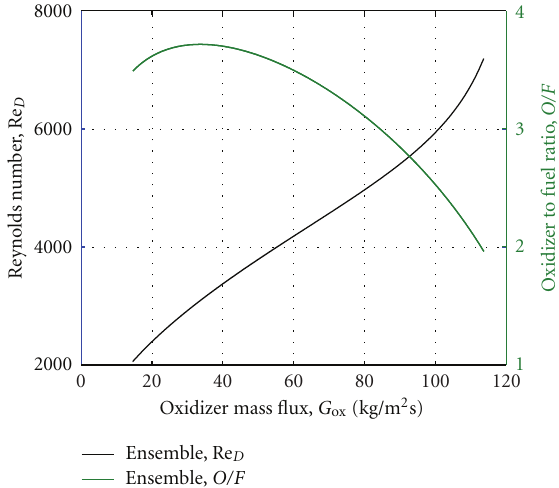
Figure 8: HTPB baseline: actual Re( G ox ) and O/F ( G ox ) for the ensemble